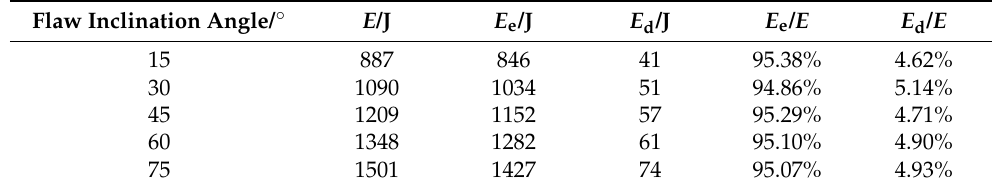
Table 4. Variation of energy ratio of sample models with different flaw inclination angles under peak